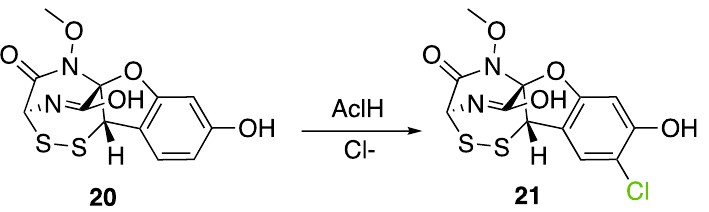
Figure 17. Chlorination of dechloroaspirochlorine ( 20 ) by AclH in A. oryzae to form aspirochlorine ( 21 ).